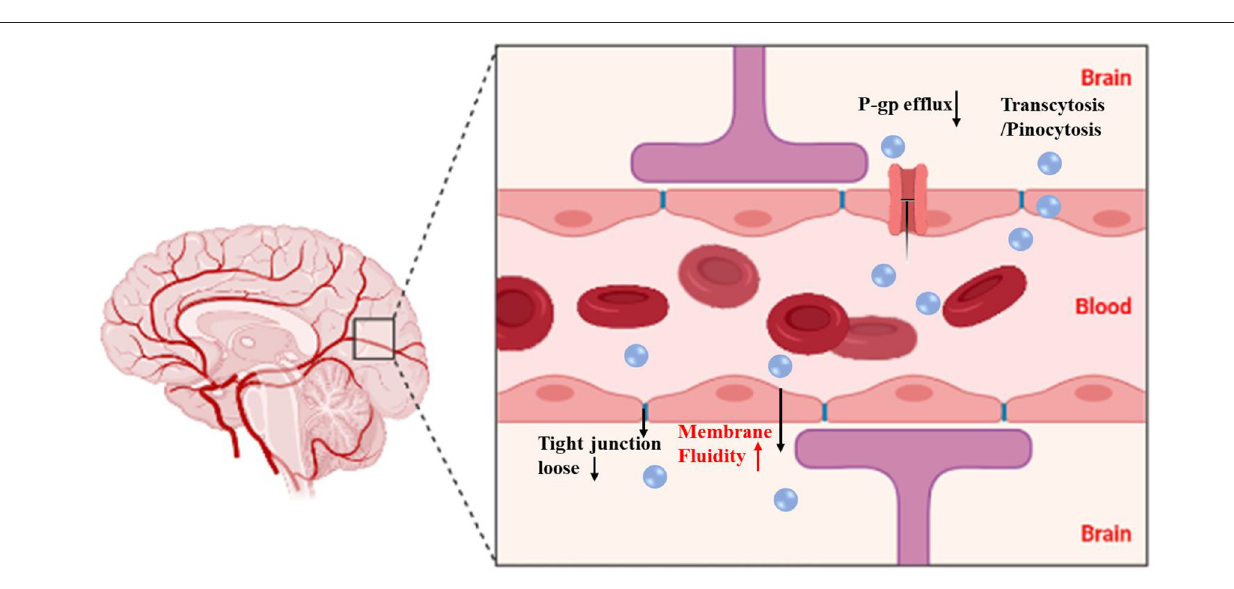
FIGURE 5 | Schematic illustration of BP-liposome transport of paclitaxel (PTX) across the blood-brain barrier (BBB) and improvement of the anti-glioma effect of PTX. The figure was created by BioRender, https://app.biorender.com/. the collision of drugs with phospholipid molecules was reduced, which promoted drug penetration through the cell